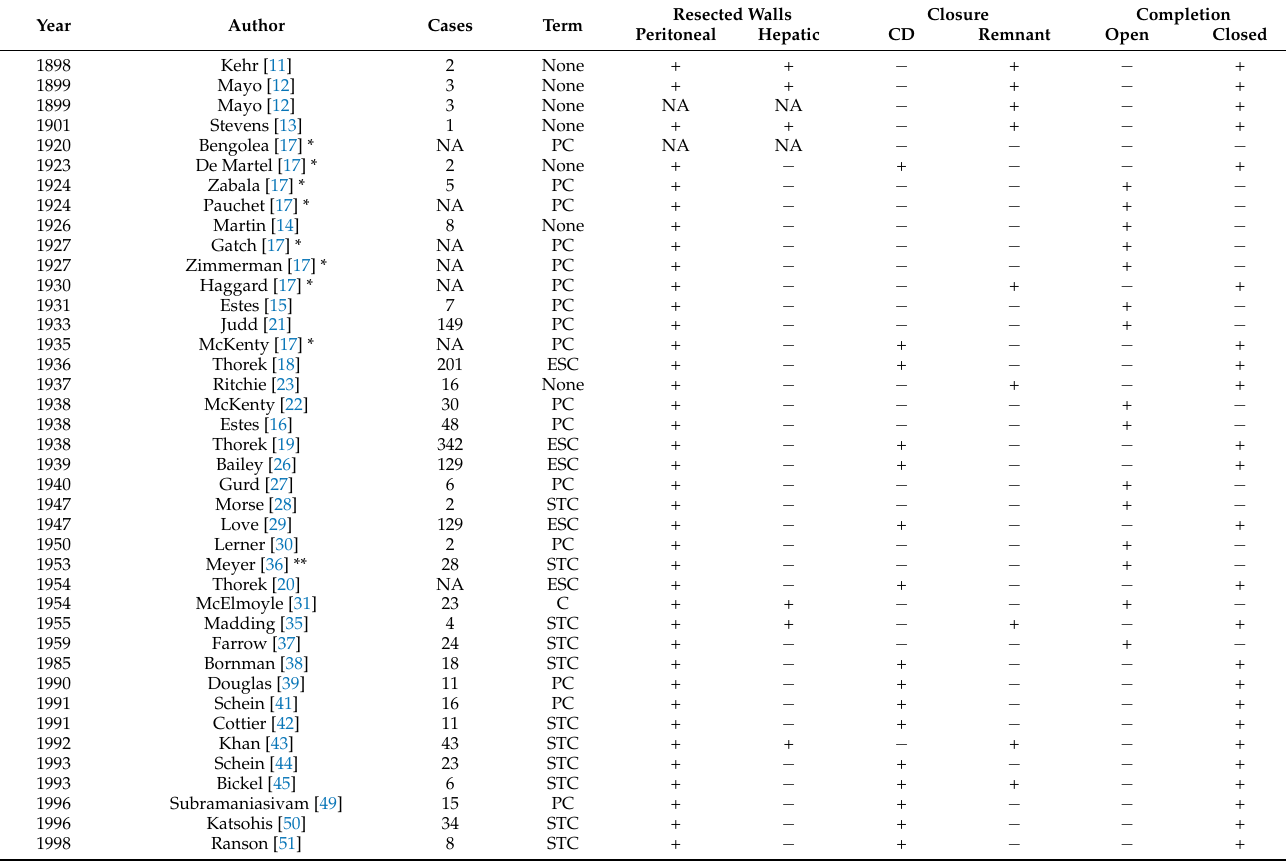
Table 2. The terms used to describe the resection of a part of the gallbladder in the historical publications and the type of operation completion, in chronological order, from 1898 to